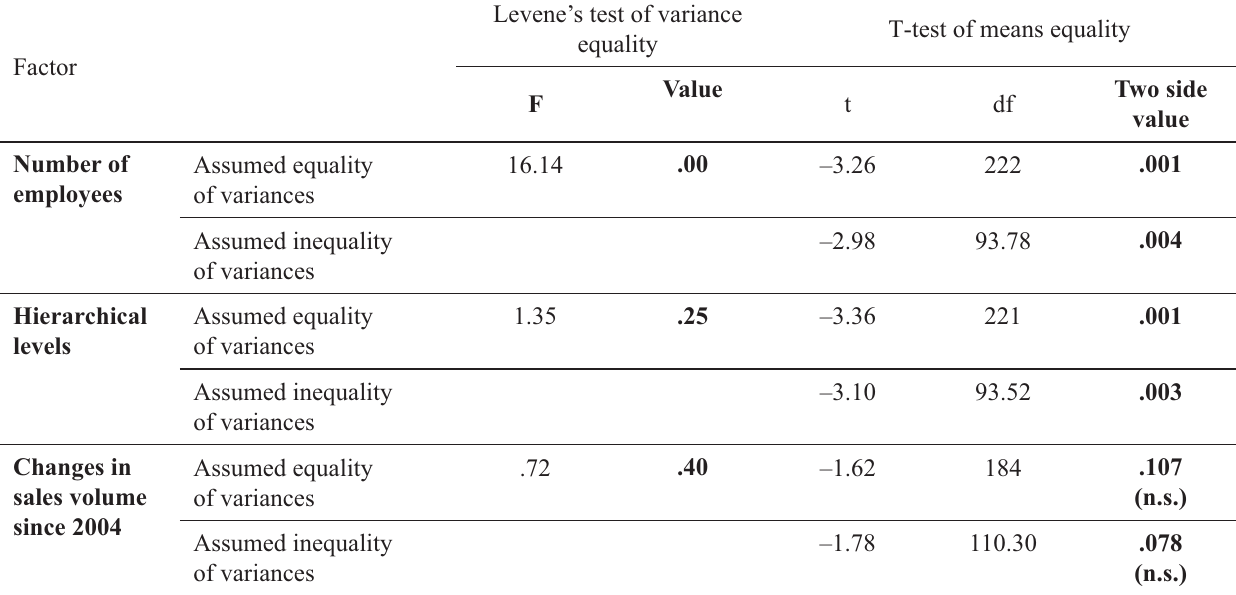
Table 2. Results of data analysis of founder-run vs manager-run companies